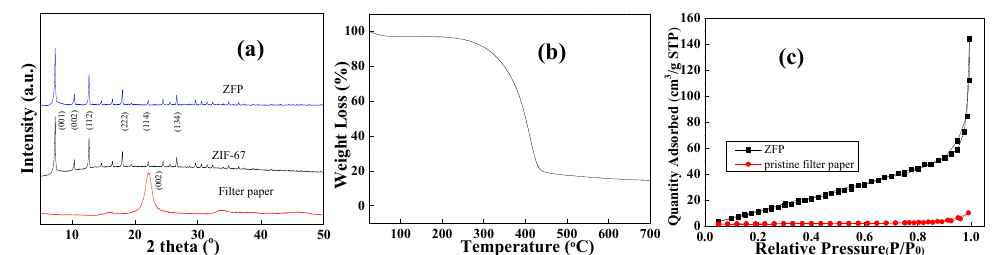
Figure 3. ( a ) XRD patterns of the prepared samples; ( b ) TGA and ( c ) N 2 adsorption/desorption curves of ZFP.